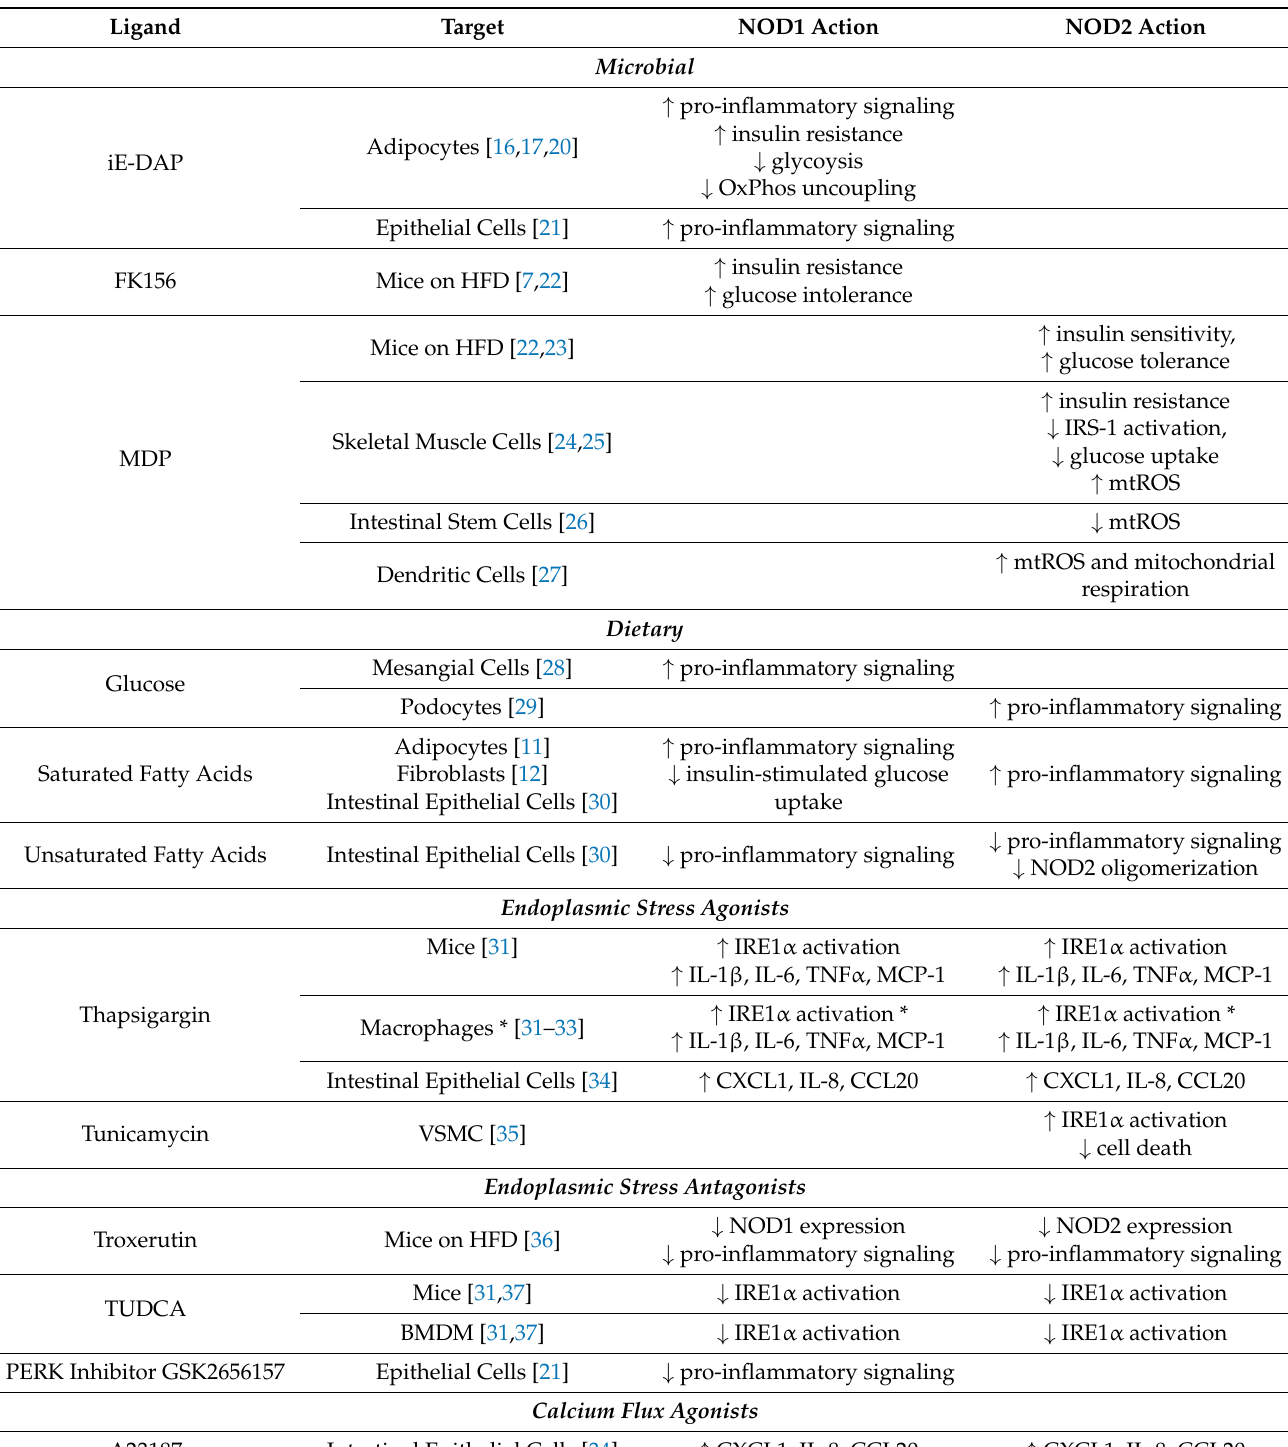
Table 1. Metabolic Actions of NOD1 and NOD2